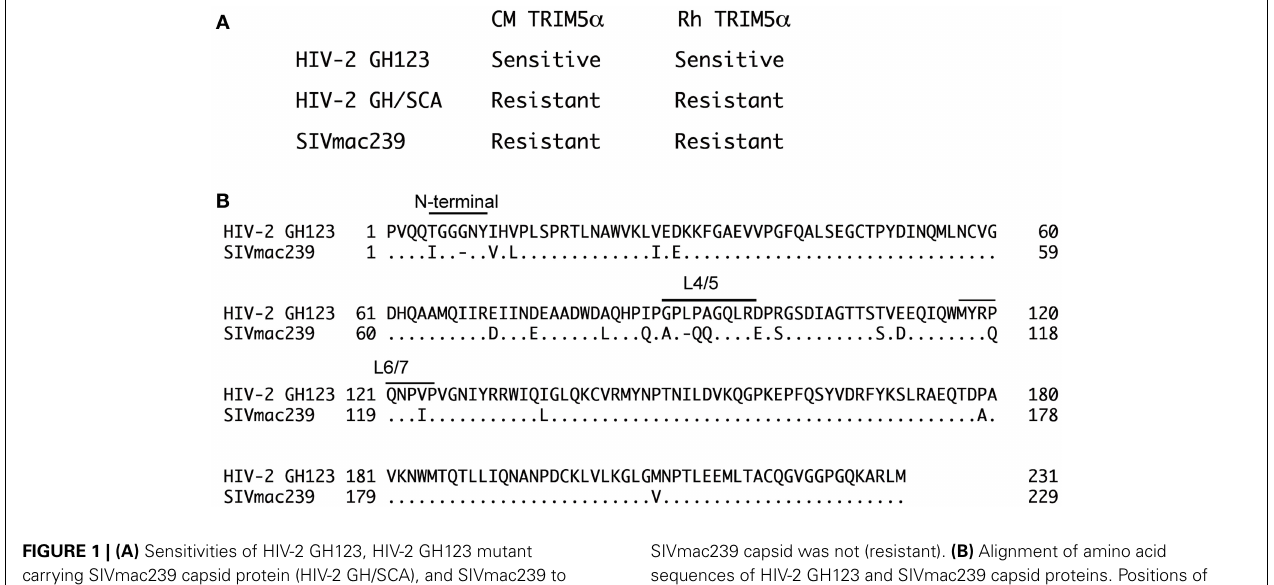
SIVmac239 capsid was not (resistant). (B) Alignment of amino acid sequences of HIV-2 GH123 and SIVmac239 capsid proteins. Positions of the N-terminal loop (N-terminal), a loop between α -helices 4 and 5 (L4/5), and a loop between α -helices 6 and 7 (L6/7) are indicated above the amino acid sequences.